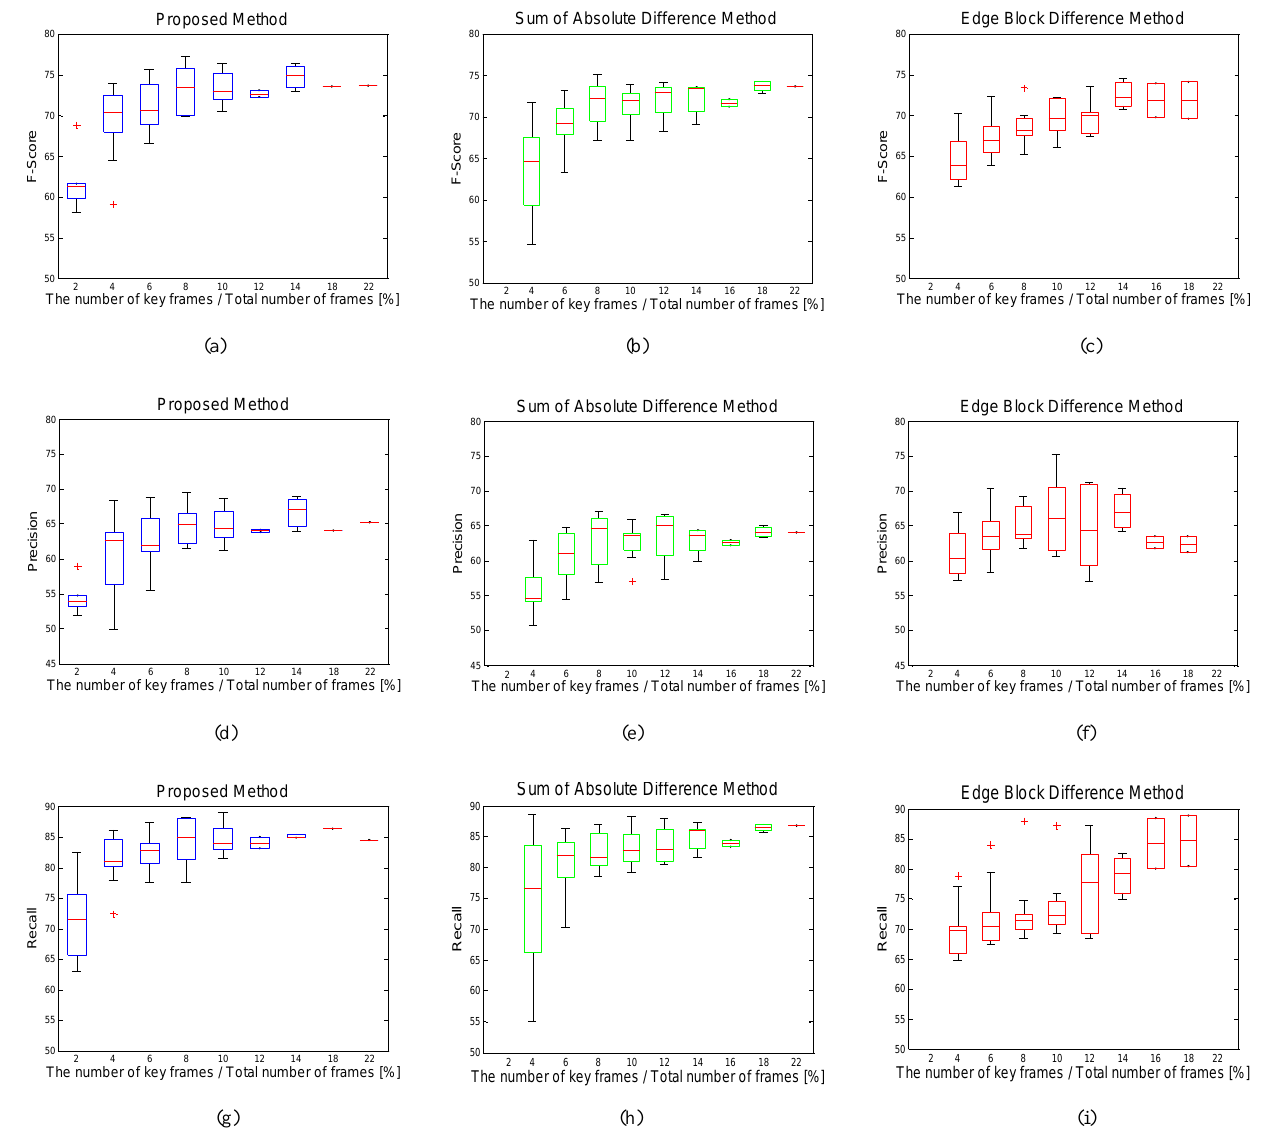
Figure 6. Performance of the proposed scheme in comparison with the baseline methods when the number of key frames is varying by thresholds and smooth operators, (a) F-Score of the proposed MSER feature, (b) F-Score of the SAD features, (c) F-Score of the EBD features, (d) Precision of the peoposed MSER features, (e) Precision of the SAD features, (f) Precision of the EBD features, (g) Recall of the proposed MSER features, (h) Recall of the SAD features, (i) Recall of the EBD